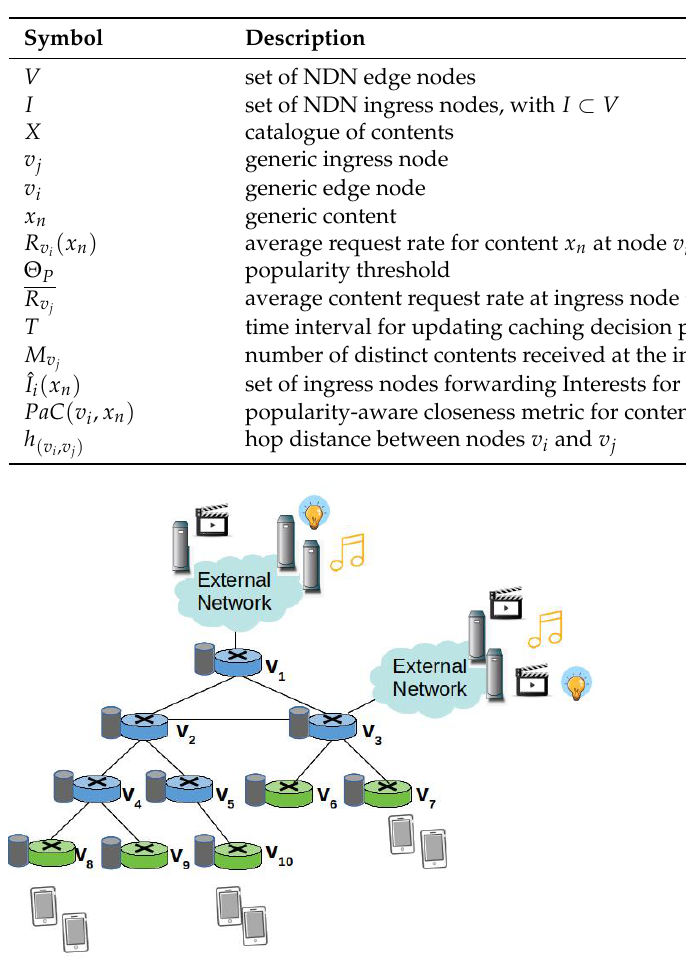
Table 2. Summary of the main notations.